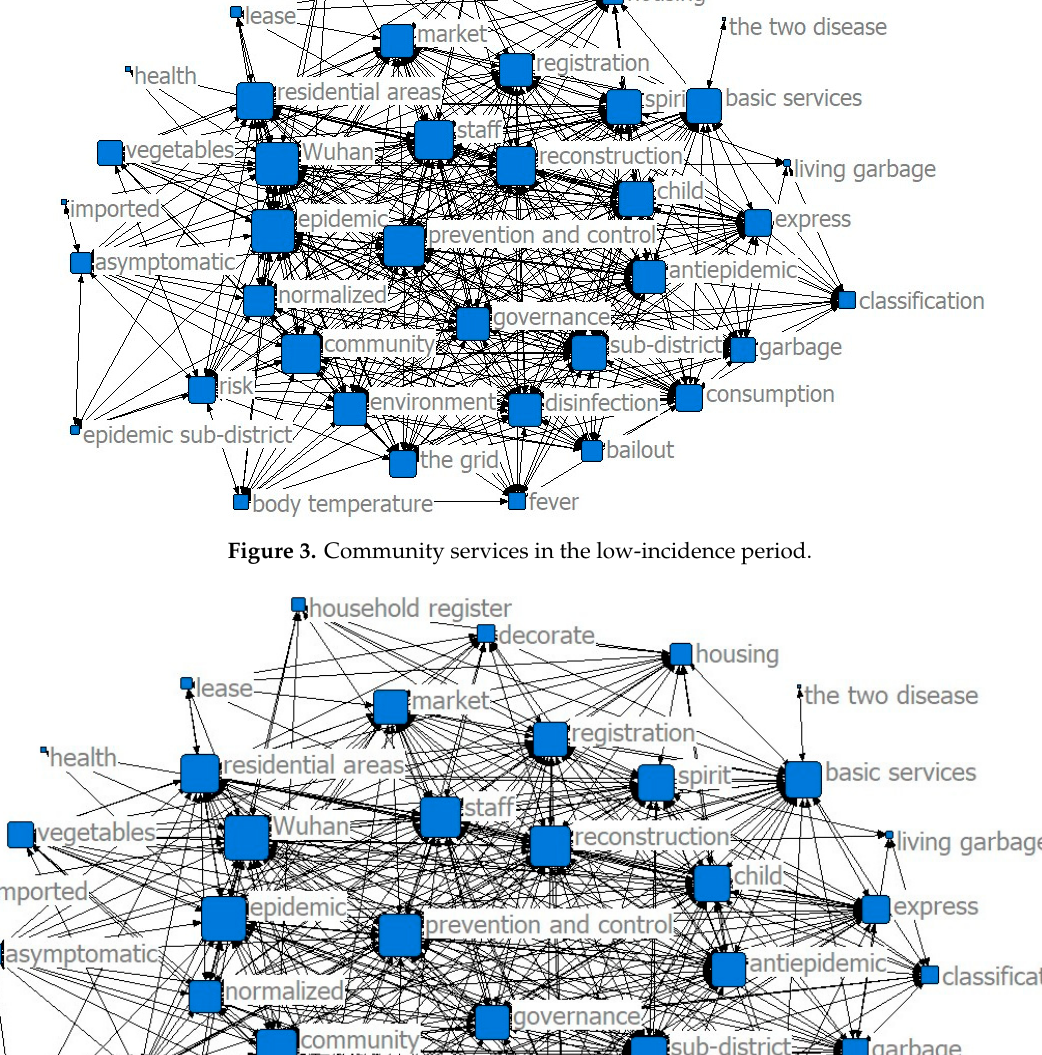
Figure 4. Community service content in the normal period.